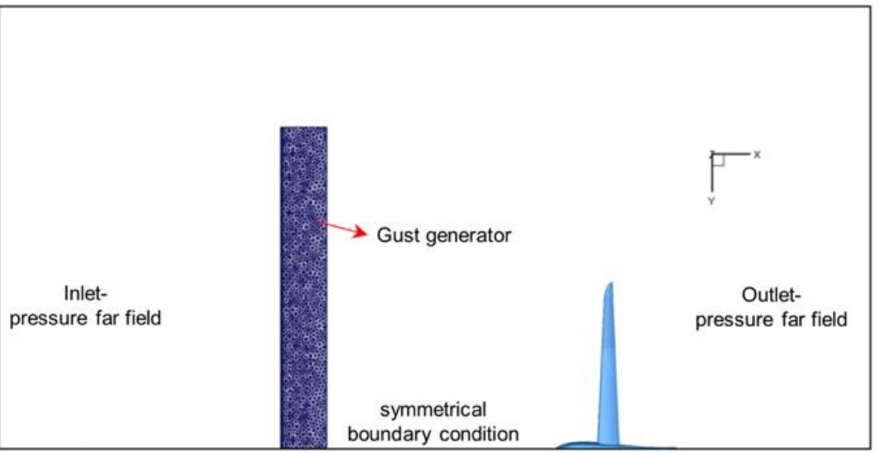
Figure 20. Simulation